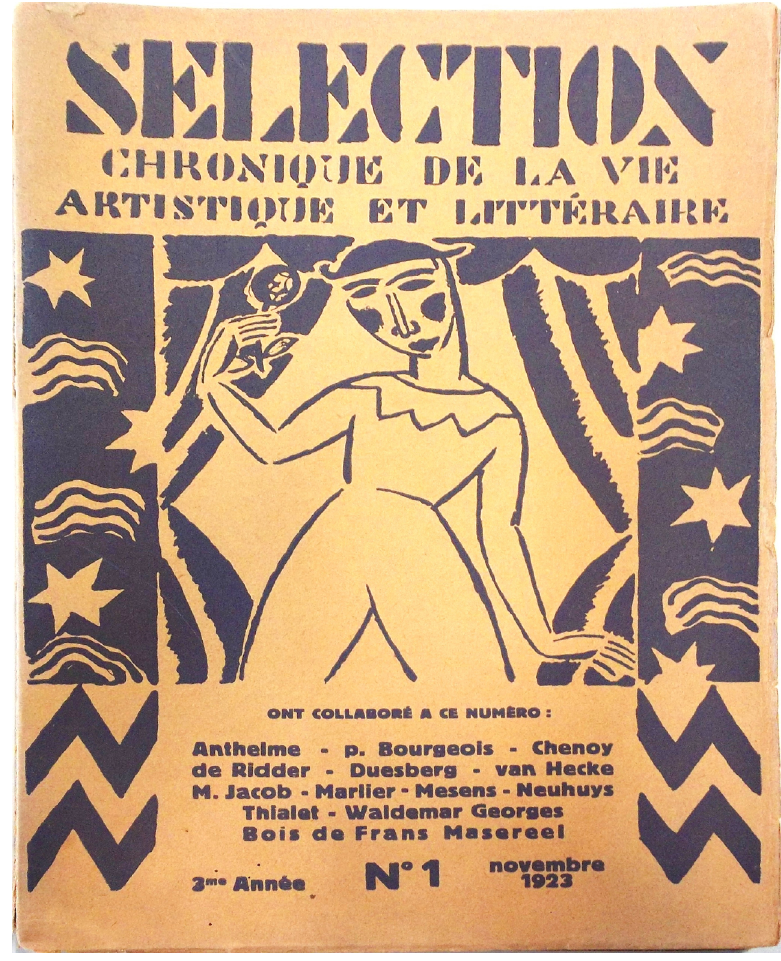
Fig. 2 Sélection , no. 1 (November 1923). Cover by Gust de